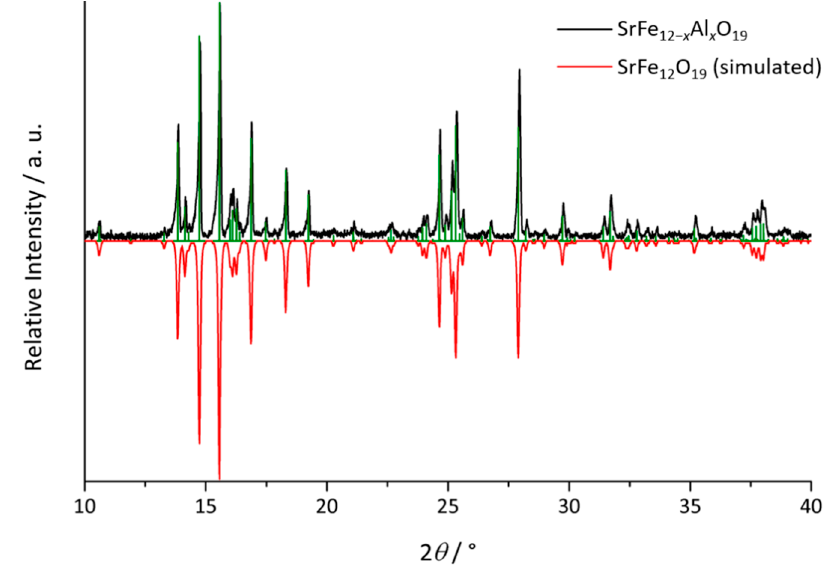
Figure 1. Powder diffraction pattern of SrFe 12 − x Al x O 19 (black, up) with marked position of reflexes (green) and simulated pattern of unsubstituted SrFe 12 O 19 (red, down [14]) measured using Mo- K α radiation.